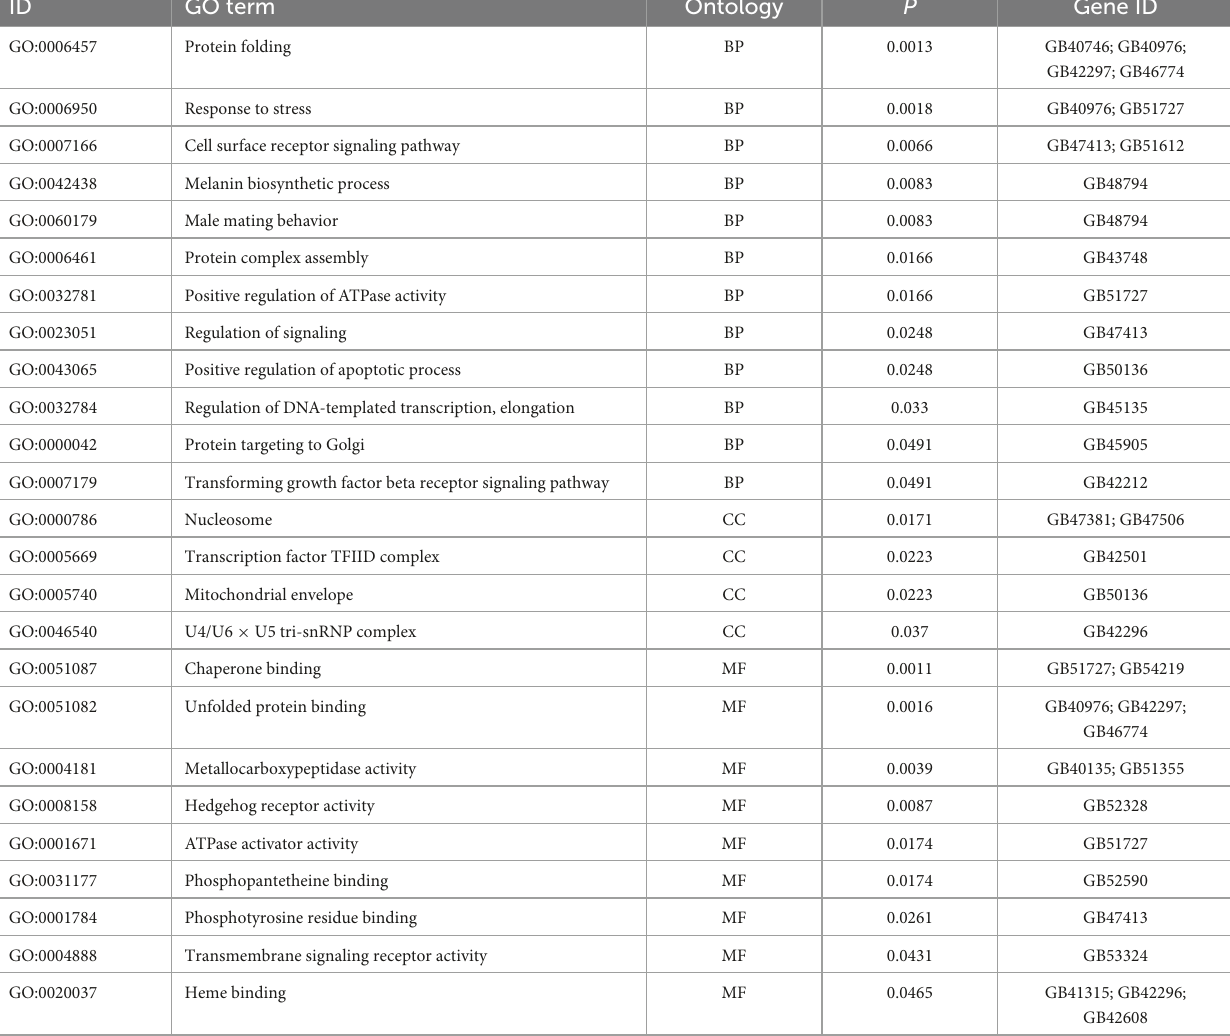
TABLE 2 Gene Ontology (GO) enrichment analysis of differentially expressed genes (DEGs) enriched in BP, CC, and